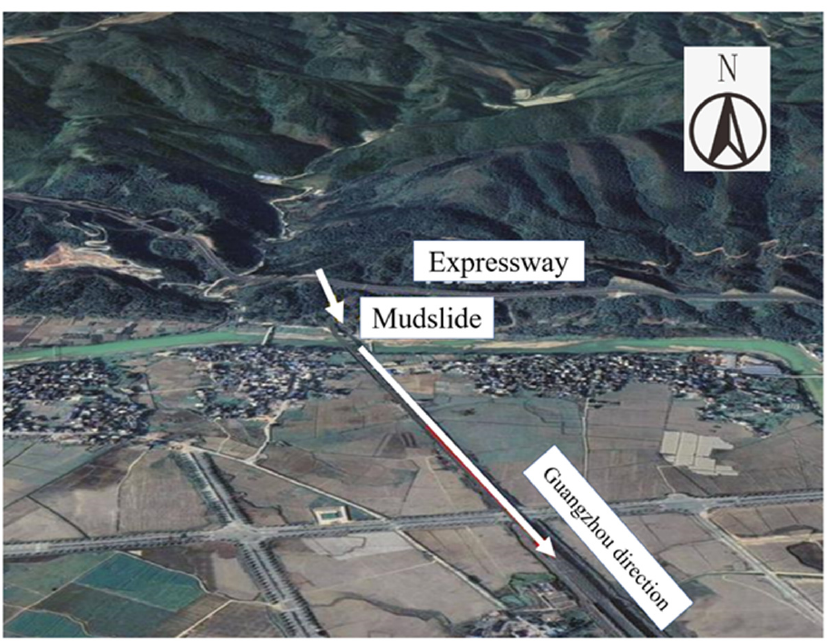
Figure 4. Accident simulation analysis diagram.